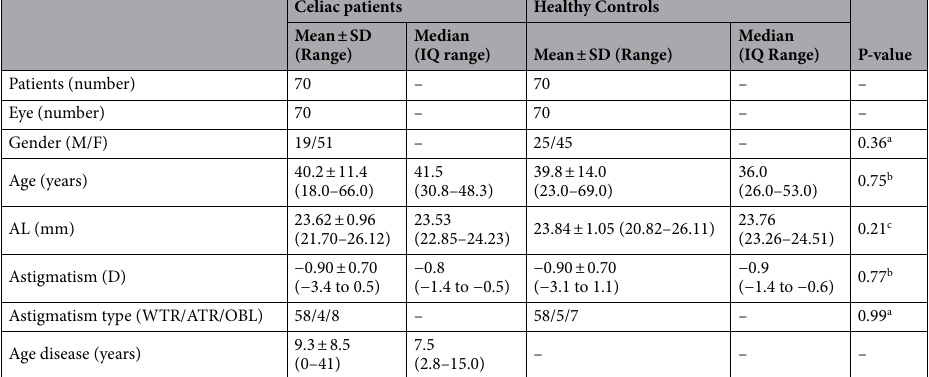
Table 1. Demographic characteristics of the two study groups. a Chi-square test with Yates correction. b Mann